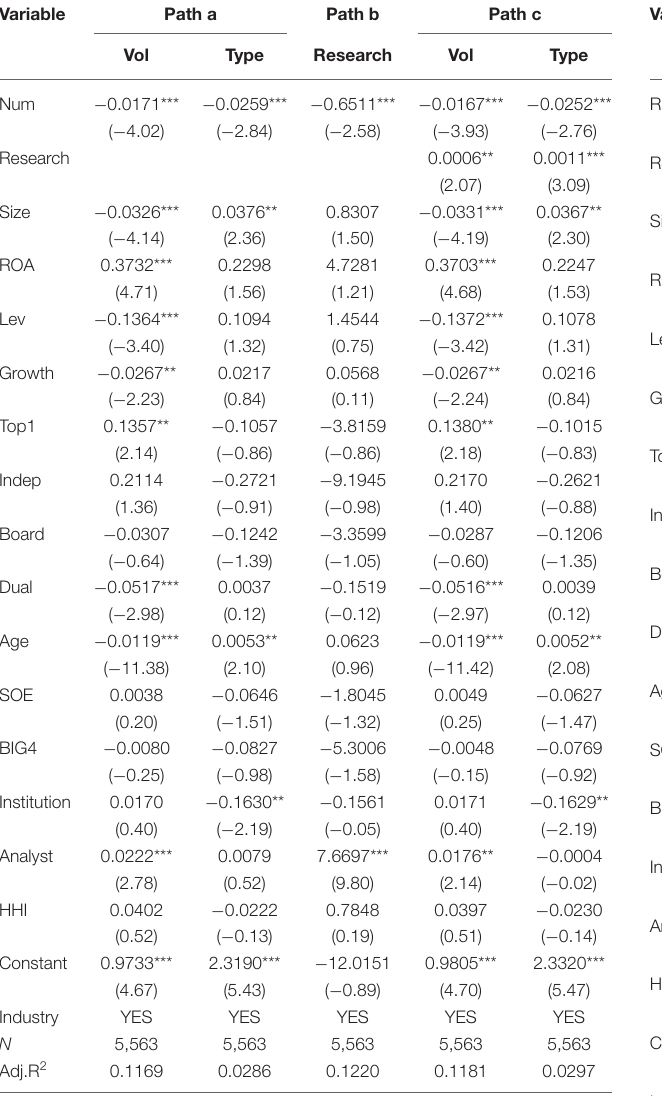
TABLE 8 | Evidence on the impact of on-site monitoring restrictions by institutional investors and analysts (X = Num). Variable